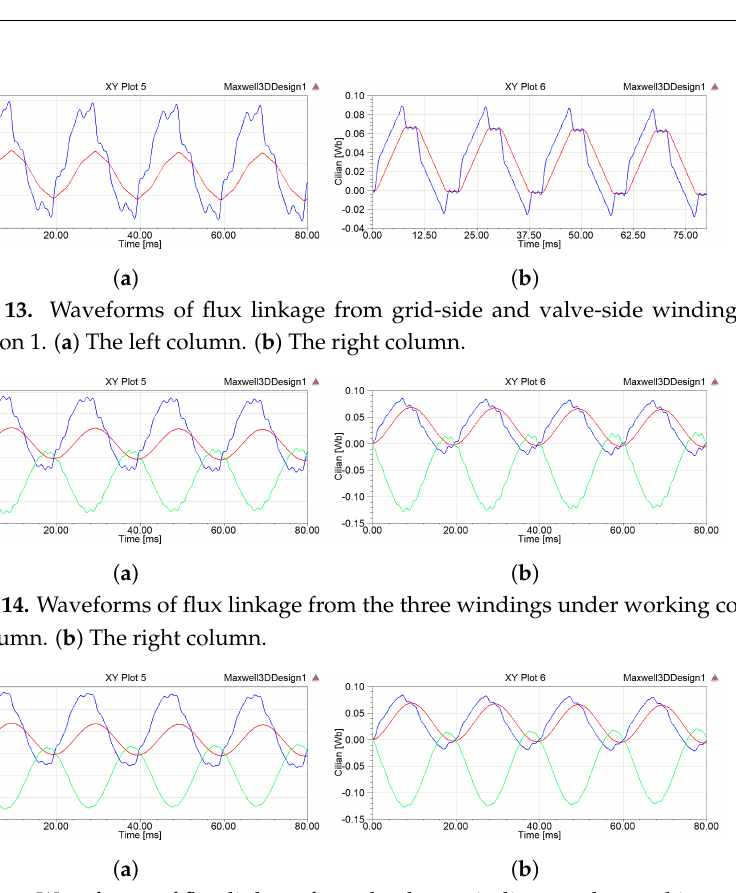
Figure 15. Waveforms of flux linkage from the three windings under working condition 3. ( a ) The left column. ( b ) The right